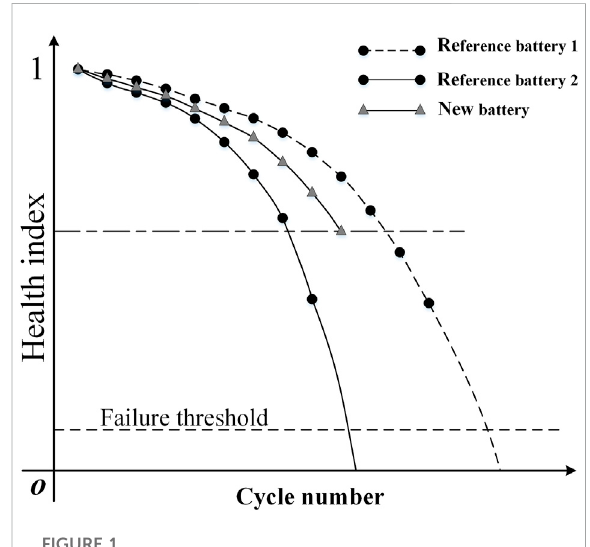
FIGURE 1 The performance degradation trajectories of the new battery and similar reference batteries.